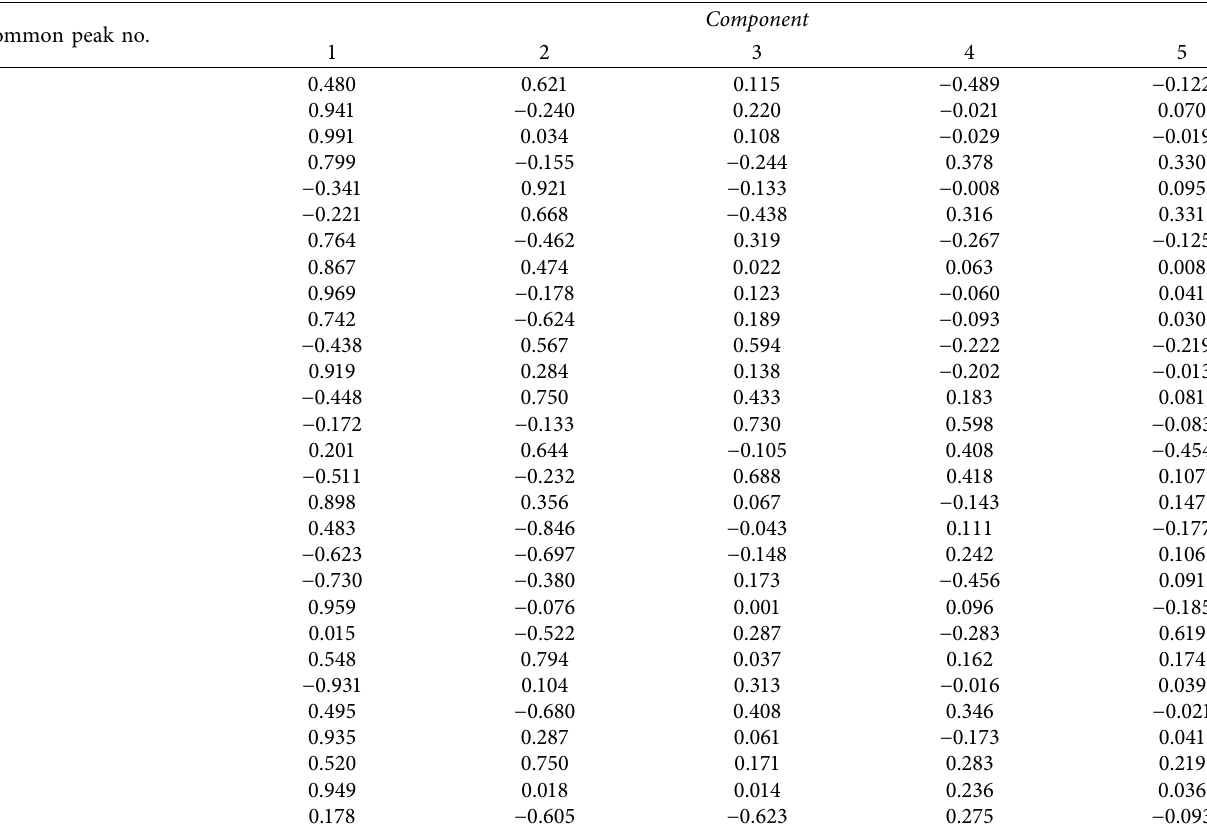
Figure 6: Reference spectrum of Yinqiao powder (a), HPLC fngerprint of 10 batches of yinqiao powder (b), scree plot of principal component of PCA (c), and VIP value of common peaks of PLS-DA (d). Table 5: Initial factor load matrix analysis of common